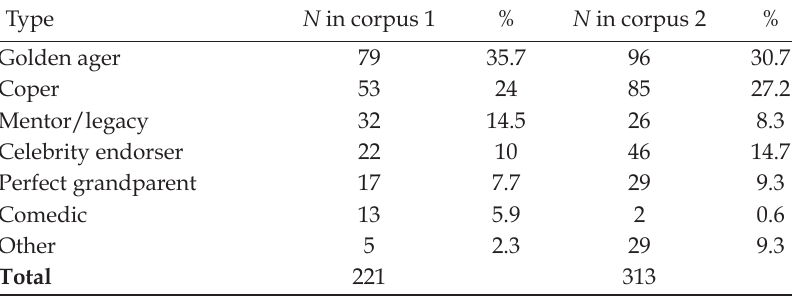
Table 5. Typology of